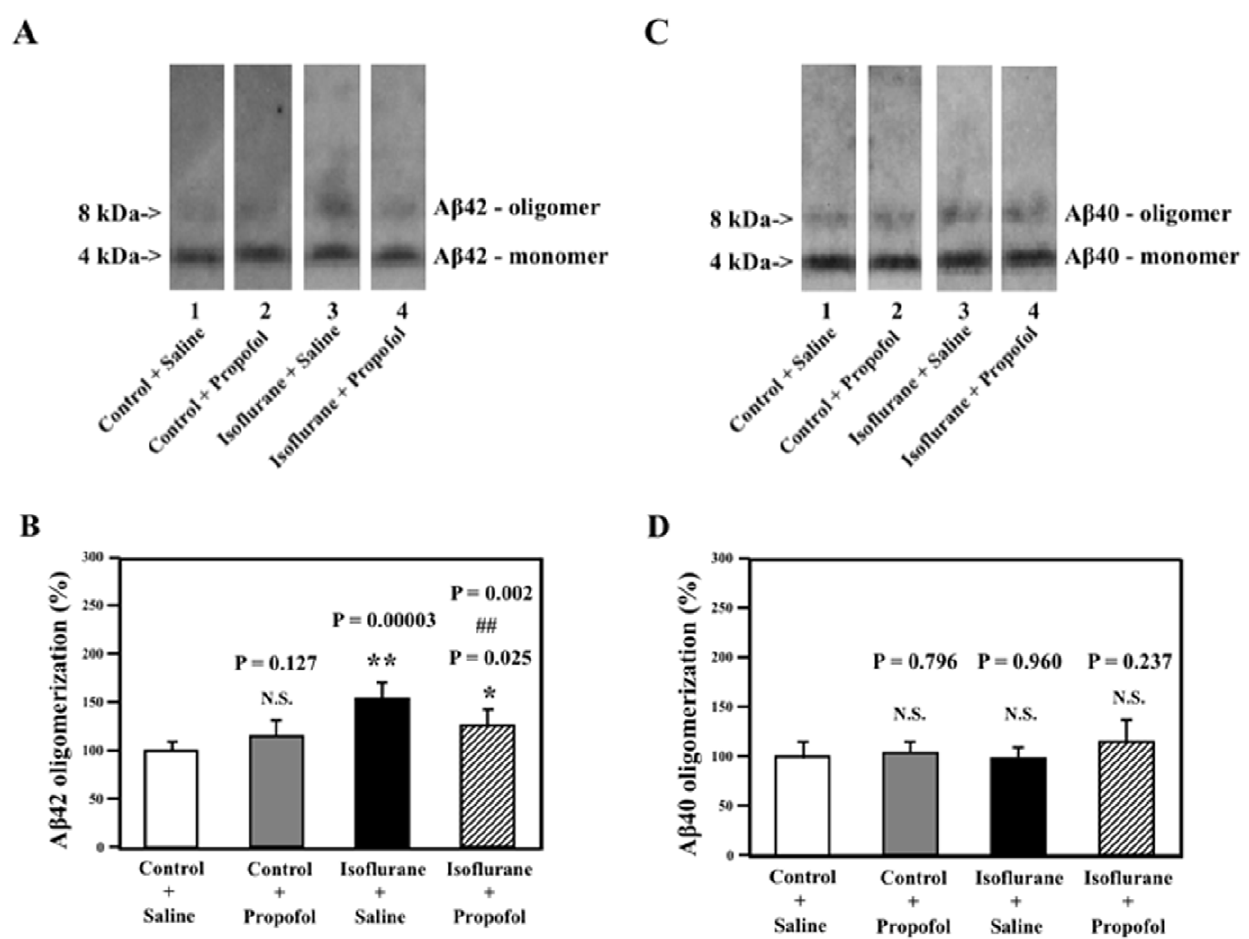
Figure 4. Propofol attenuates the isoflurane-induced A b 42, but not A b 40, oligomerization, in conditioned cell culture media. A. Treatment with 2% isoflurane for six hours (lanes 3) induces A b 42 oligomerization as compared to the control condition (lanes 1). The treatment of propofol alone (lanes 2) does not affect A b 42 oligomerization as compared to the control condition (lanes 1). However, the propofol treatment (lanes 4) attenuates the 2% isoflurane-induced A b 42 oligomerization as compared to 2% isoflurane alone (lanes 3). B. Quantification of the Western blot shows that 2% isoflurane (black bar) induces A b 42 oligomerization as compared to control condition (white bar), ** P=0.00003. The propofol treatment alone (gray bar) does not affect A b 42 oligomerization as compared to control condition (white bar). However, two-way ANOVA shows that the propofol treatment (net bar) attenuates the isoflurane-induced A b 42 oligomerization, # P=0.002. C. Treatment with 2% isoflurane alone (lanes 3), propofol alone (lane 2) or isoflurane plus propofol (lane 4) do not affect A b 40 oligomerization as compared to the control condition (lanes 1). D. Quantification of the Western blot 2shows that 2% isoflurane alone (black bar), propofol alone (gray bar) or propofol plus isoflurane (net bar) do not affect A b 40 oligomerization as compared to control condition (white bar).